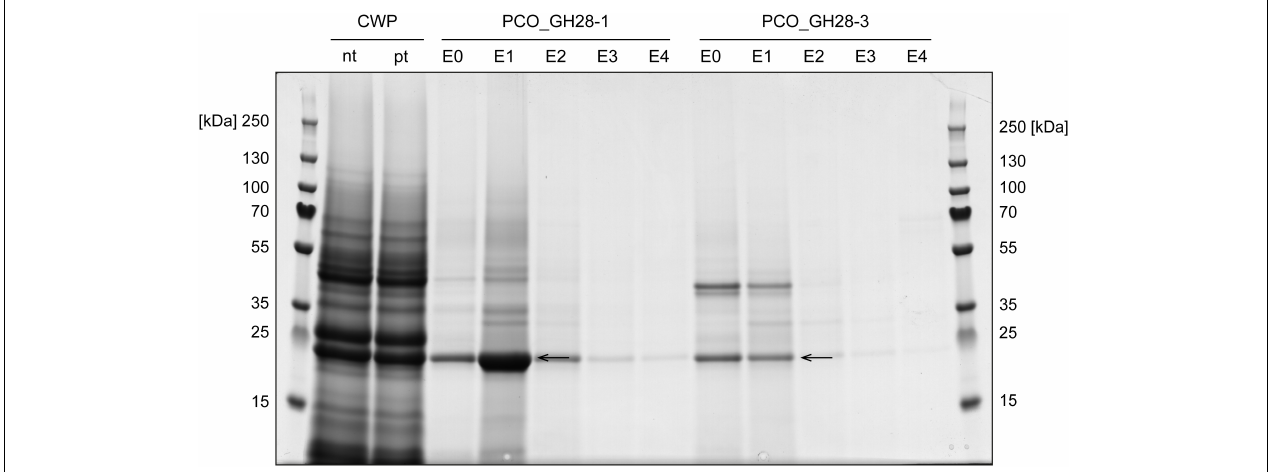
FIGURE 1 | SDS-PAGE of pull-down assay of PCO_GH28-1 and -3 with B. rapa ssp. pekinensis cell wall proteins (CWPs). Non-treated (nt) CWP extracts were pre-treated (pt) with column resin to reduce unspecific binding to the PCO_GH28 columns and then passed over columns with immobilized purified PCO_GH28-1 and -3. Elution fractions E1 were analyzed by LC-MS/MS. A protein band detected in the negative control as well ( Supplementary Figure 5 ) is indicated by the arrows. For detailed information on interacting LRR and total proteins, see Tables 1 , 2 as well as Supplementary Tables 4–6 . E0–4: elution fractions